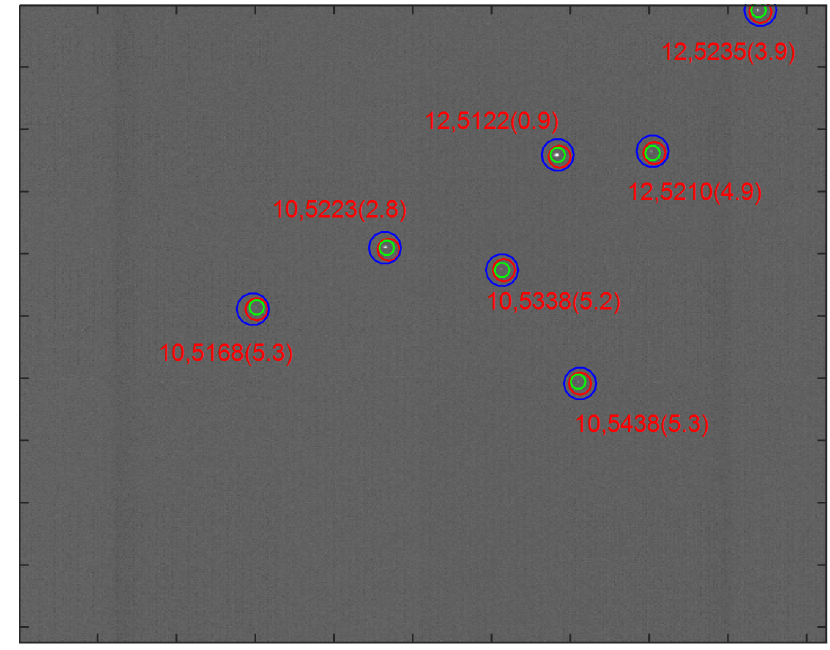
Figure 9. An example of the identification results in real star